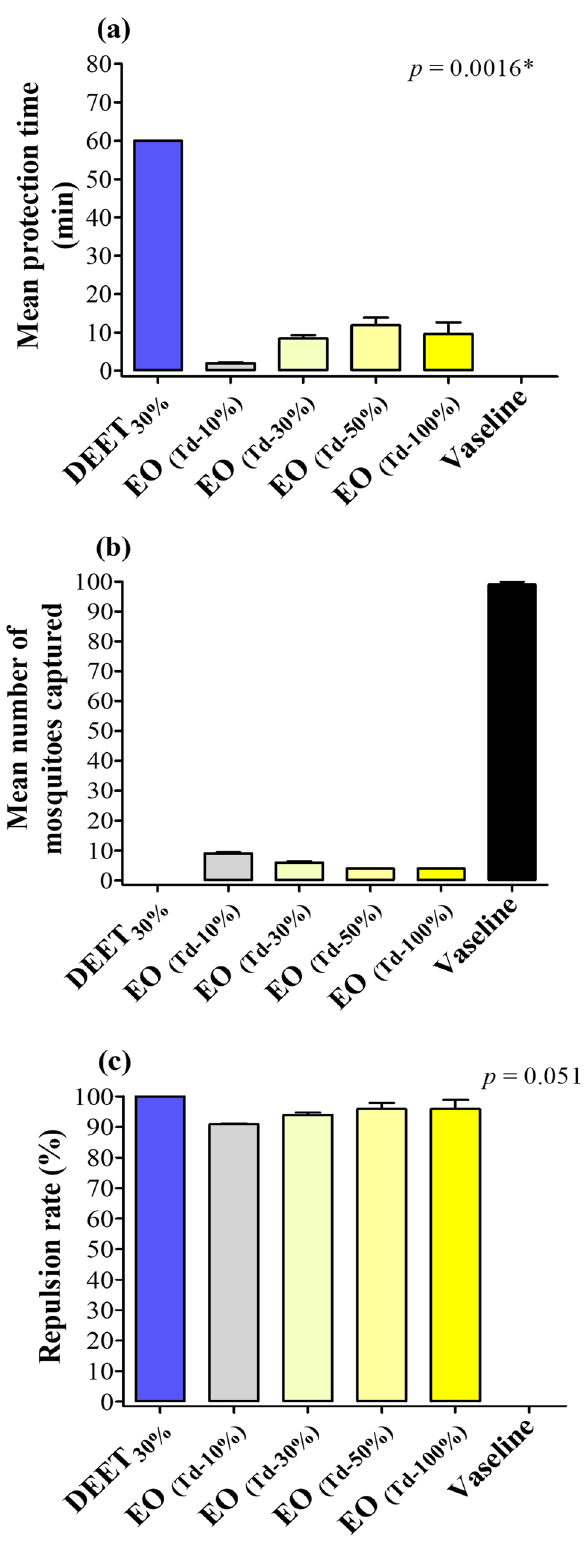
Figure 5. Findings from the in vitro repellency activity. ( a ) Mean protection time, ( b ) Number of mosquitoes captured after 1 h, ( c ) Repulsion rate after 1 h. DEET: N, N-diethyl-3-methylbenzamide (positive control); EO (Td-X%) : Essential oil of T. diversifolia at dose 10%, 30%, 50% and 100%; Kruskal–Wallis test was used to make comparisons between the groups; *Statistically significant at p <